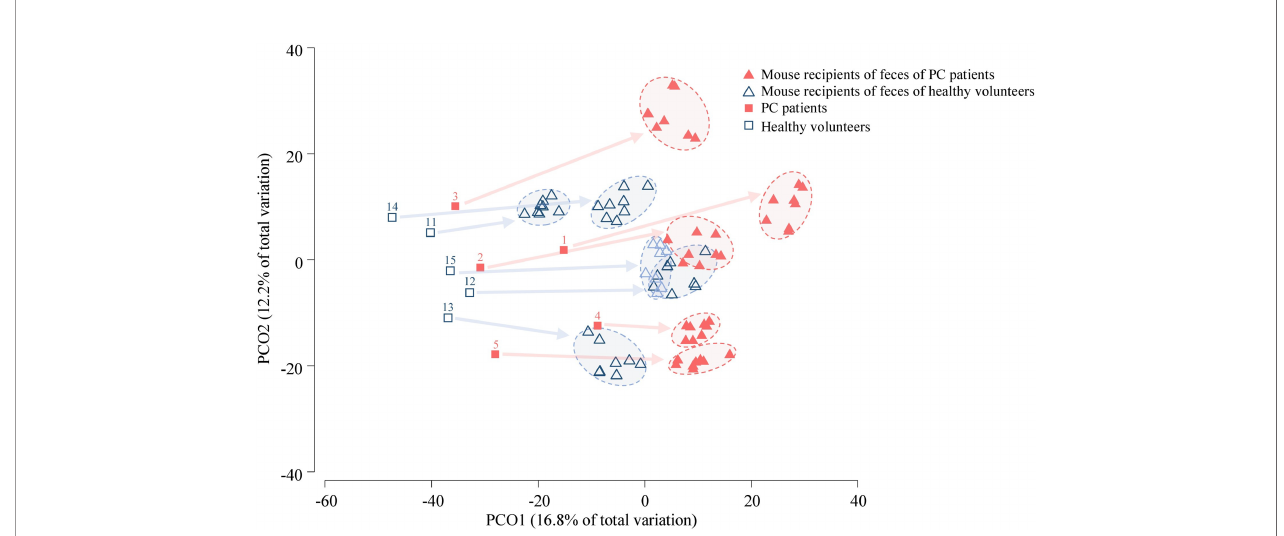
FIGURE 2 | PCoA of human (n = 10) and mouse fecal microbiota (n = 20). The samples from a pair of mice who were transplanted from the same human donor, and collected at four time-points are surrounded by an oval (4 samples per mouse, 8 mouse samples for one human donor). The numbers correspond to human donors. Arrows link the human donor sample to fecal samples from corresponding transplanted mice. The analysis was based on the relative abundance of